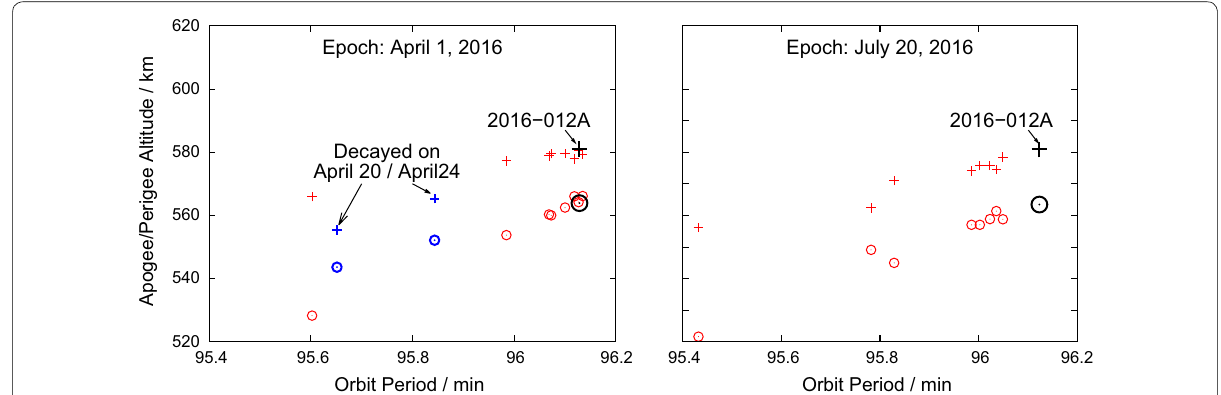
Fig. 4 Gabbard diagram of the Hitomi debris. Left first TLEs were published for April 1. Right TLEs for July 20. ‘ perigee altitude. Black marks indicate Hitomi main body. Red marks indicate fragments still in orbit on July 20. Blue marks indicate fragments 41438 and 41443 which decayed end of April (see also Table